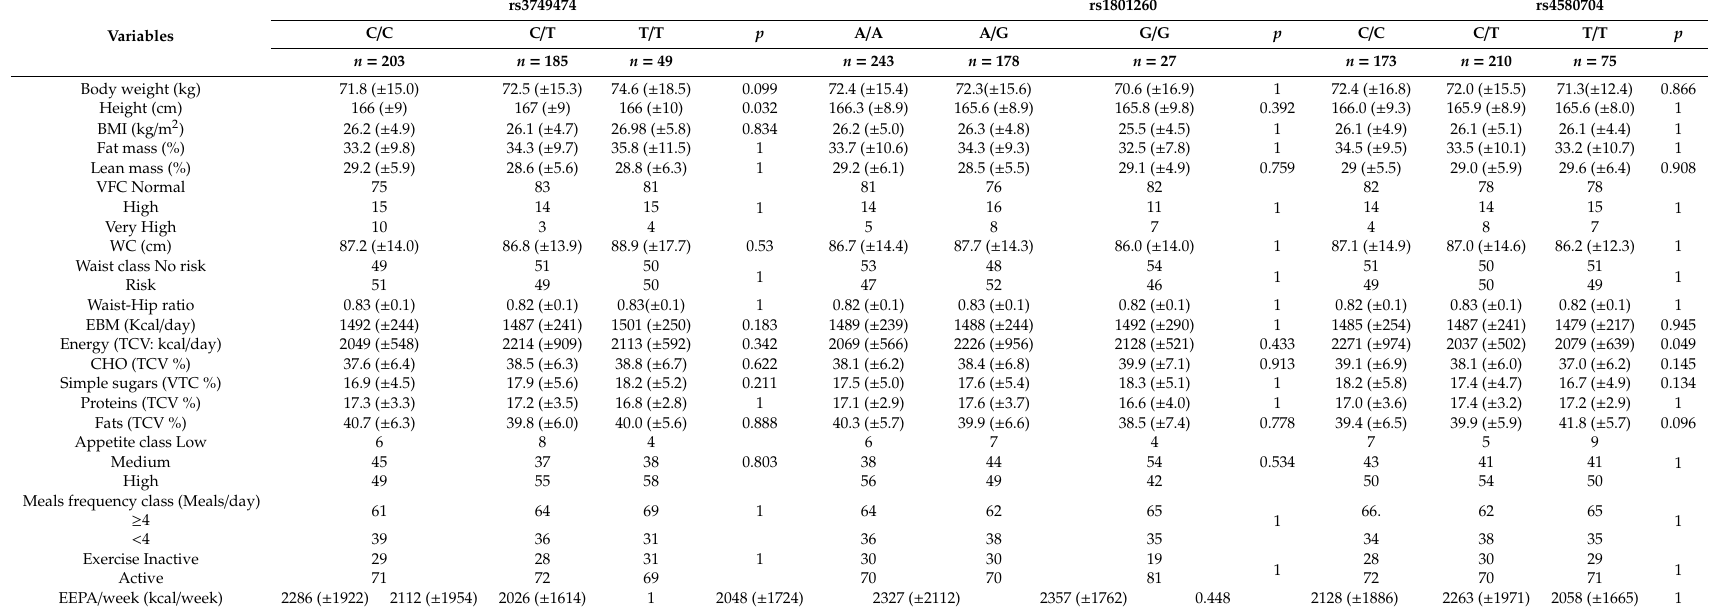
Table 2. Association of CLOCK SNPs with studied variables (X ± SD;